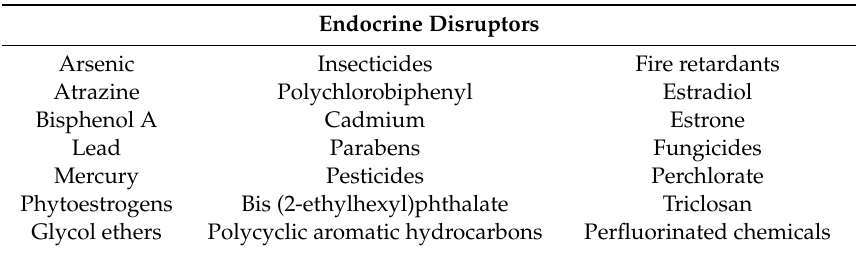
Table 1. List of main endocrine